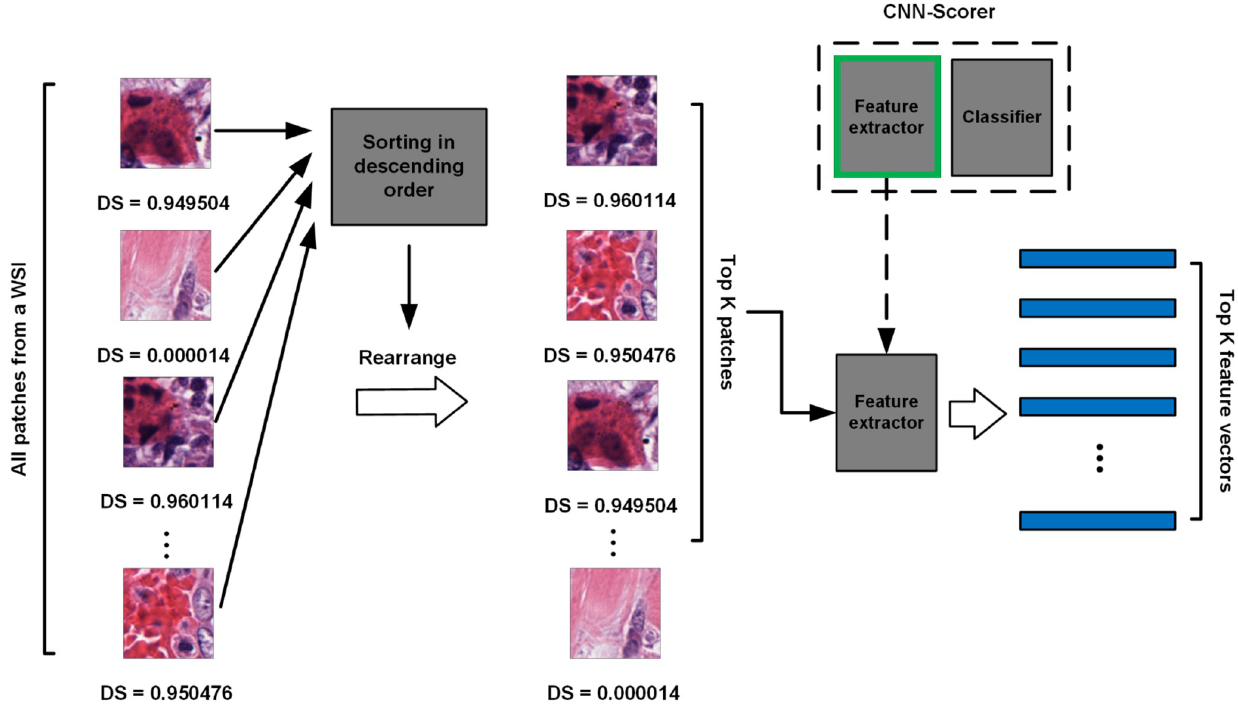
Fig 4. Intelligent sampling. All the patches from the tumor region of a WSI are scored by the pretrained CNN-scorer and then rearranged according to their DSs in descending order. The top K patches are sampled as the most discriminative for this WSI. The sampled patches are fed into the same CNN as a feature extractor (i.e., without the classification head) to be embedded into feature vectors. The top K extracted feature vectors act as a bag of instances for subsequent training of an MIL model.